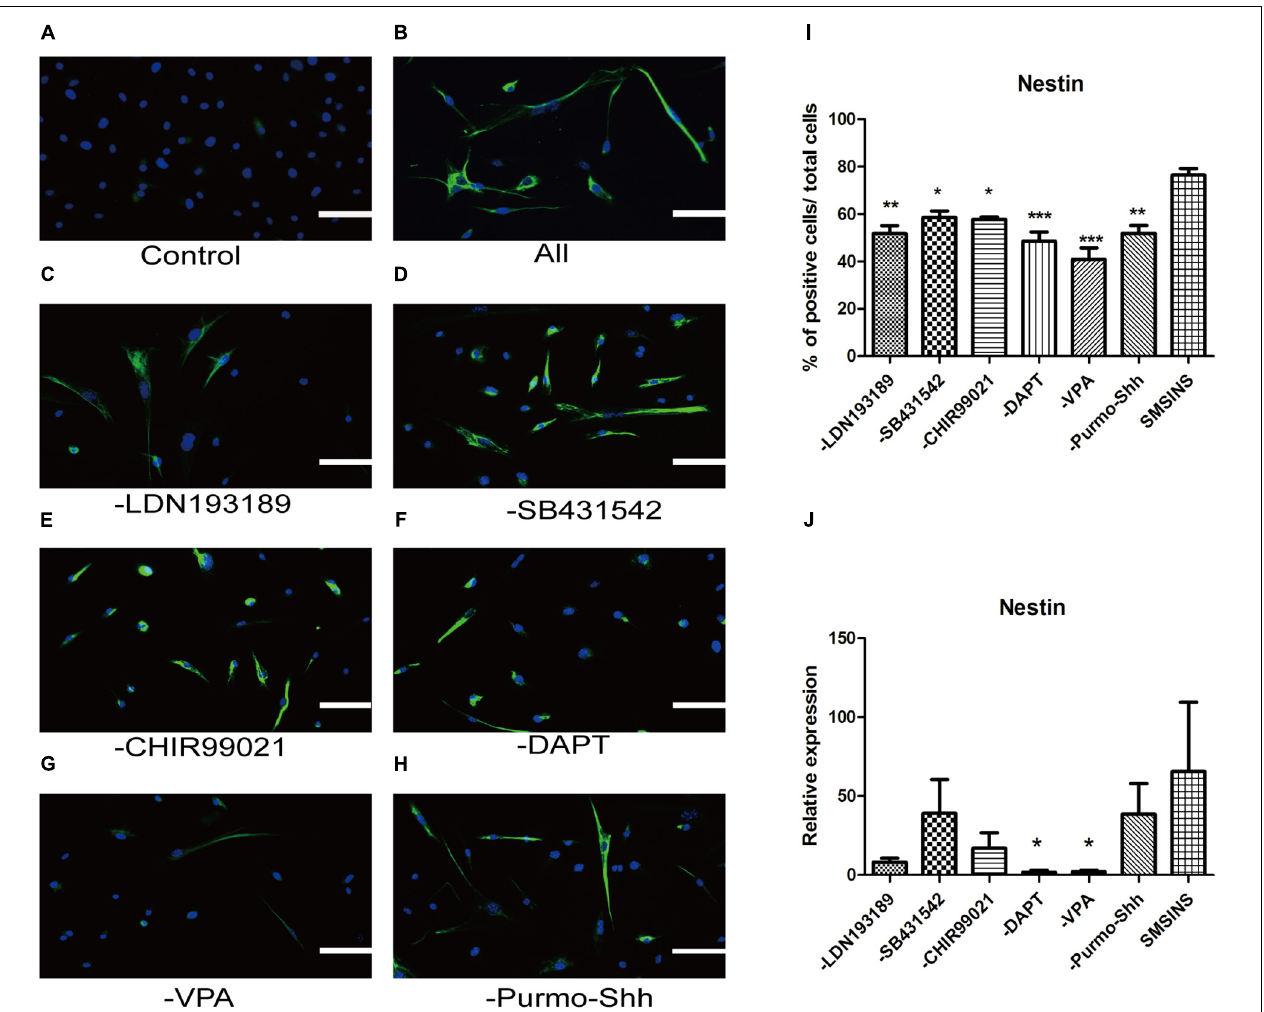
FIGURE 6 | Evaluating the essential role of each small molecule during reprogramming. (A) MEFs treated with 1% DMSO as a control. (B) A staged combination of seven small molecules induced a massive number of Nestin (Green). (C–F) Individual removal of LDN193189 (C) , SB431542 (D) , CHIR99021 (E) , DAPT (F) , VPA (G) , or Purmo + Shh (H) from the pool of seven small molecules reduced the number of converted iNSCs. Nuclei were counterstained with DAPI (blue). Scale bars: 100 µ m. (I) Quantitative analyses show that VPA is the most potent reprogramming factor, followed by DAPT, LDN193189, Purmo + Shh, CHIR99021 and SB431542. F = 8.863 ∗ p < 0.05; ∗∗ p < 0.01; ∗∗∗ p < 0.001 compared with SMSINS; One-way ANOVA followed with Dunnett’s T3 test. (J) qRT-PCR analyses of removal each Individual small molecule from induced program; ∗ p < 0.05; ∗∗ p < 0.01; ∗∗∗ p < 0.001 compared with SMSINS; Non-parametric tests was used. Data represent the mean ± SEM. GAPDH was used as a loading